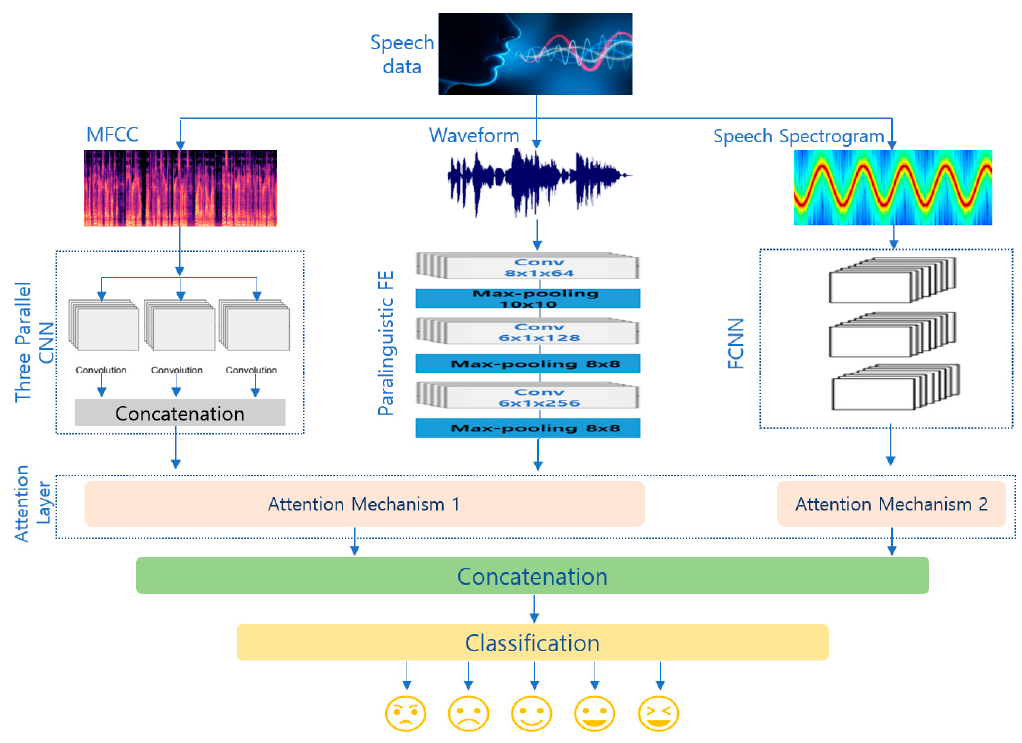
Figure 2. Workflow of the proposed model.